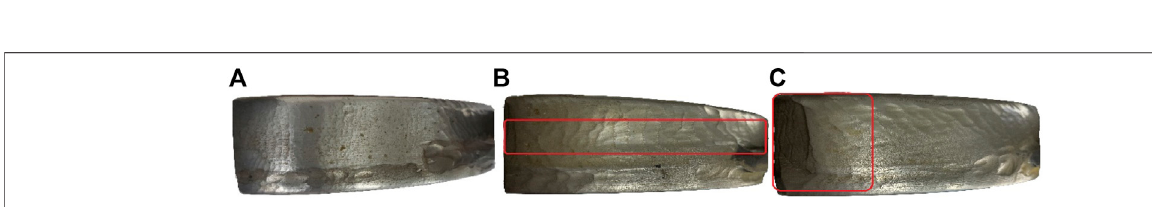
FIGURE 7 | Pressure surface wear under different mass concentration. (A) 15%, (B) 20%, and (C) 30%.